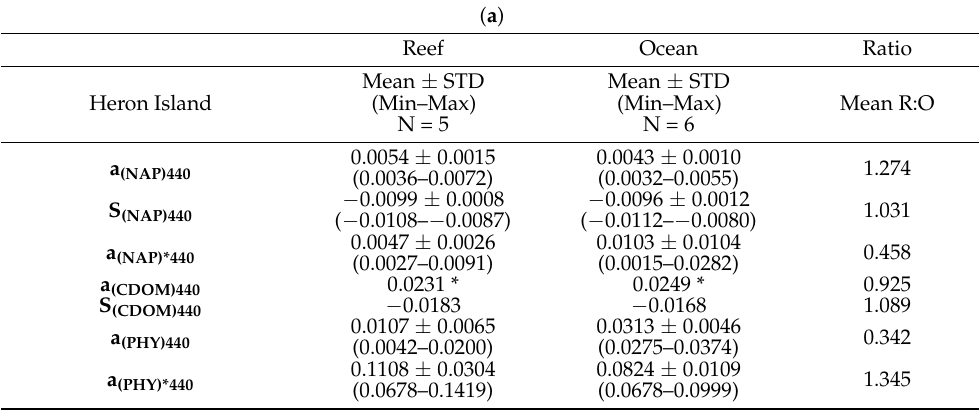
Table 2. ( a ) Heron Island 2004 ( b ) Coringa Herald Cays 2006 ( c , d ) Lihou Reefs 2008 fieldwork and laboratory results for optically active constituent concentrations, and absorption related IOPs and SIOPs. (( a ): * only one CDOM measurement each available for reef and ocean; ( c ): including two intermediate tide samples). a( NAP )* 440 in units of m 2 mg − 1 and a( PHY )* 440 in units of m 2 µ g − 1 . R:O = Reef to Ocean